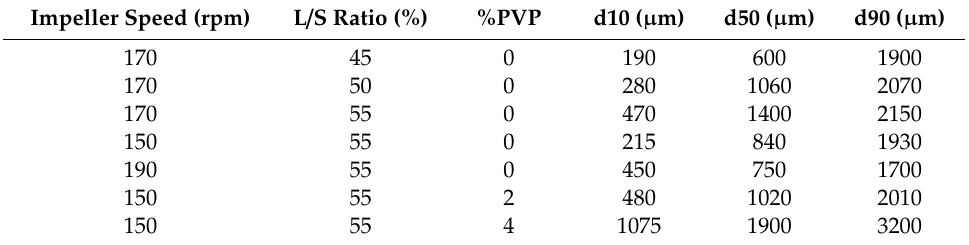
Table 2. DoE for e ff ect of granulation and formulation parameters on